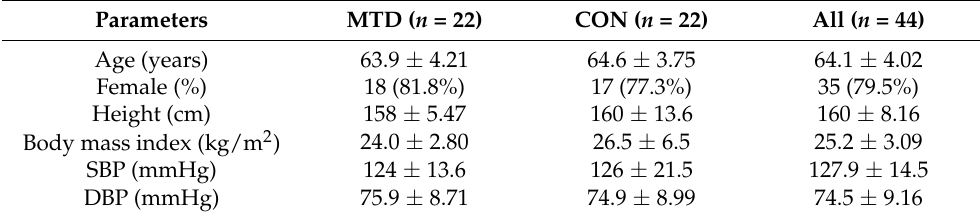
Table 1. Demographic and clinical characteristics of all the